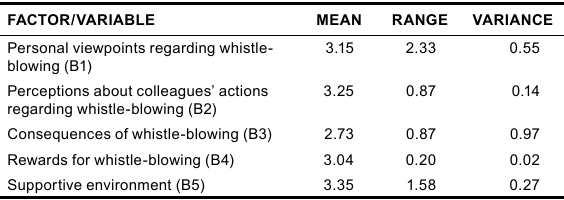
Table 2 Descriptive statistics for whistle-blowing